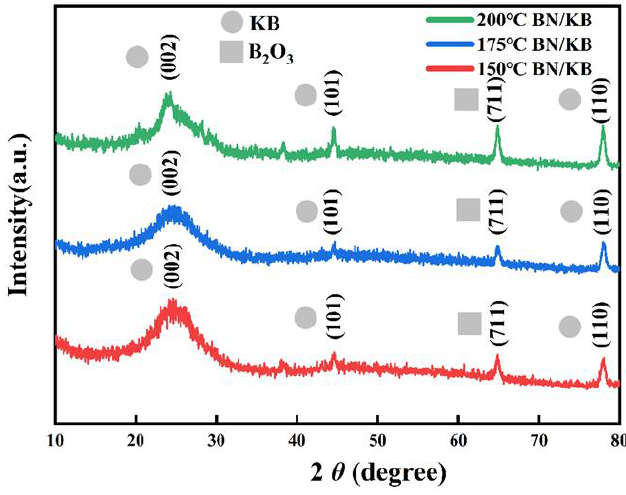
Figure 5. XRD of BN/KB material at 200 °C, 175 °C, 150 °C.